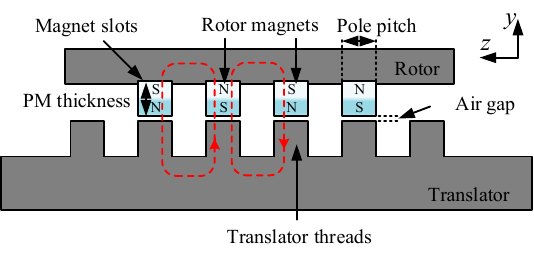
Figure 3. 2D symmetric view of the RLS.